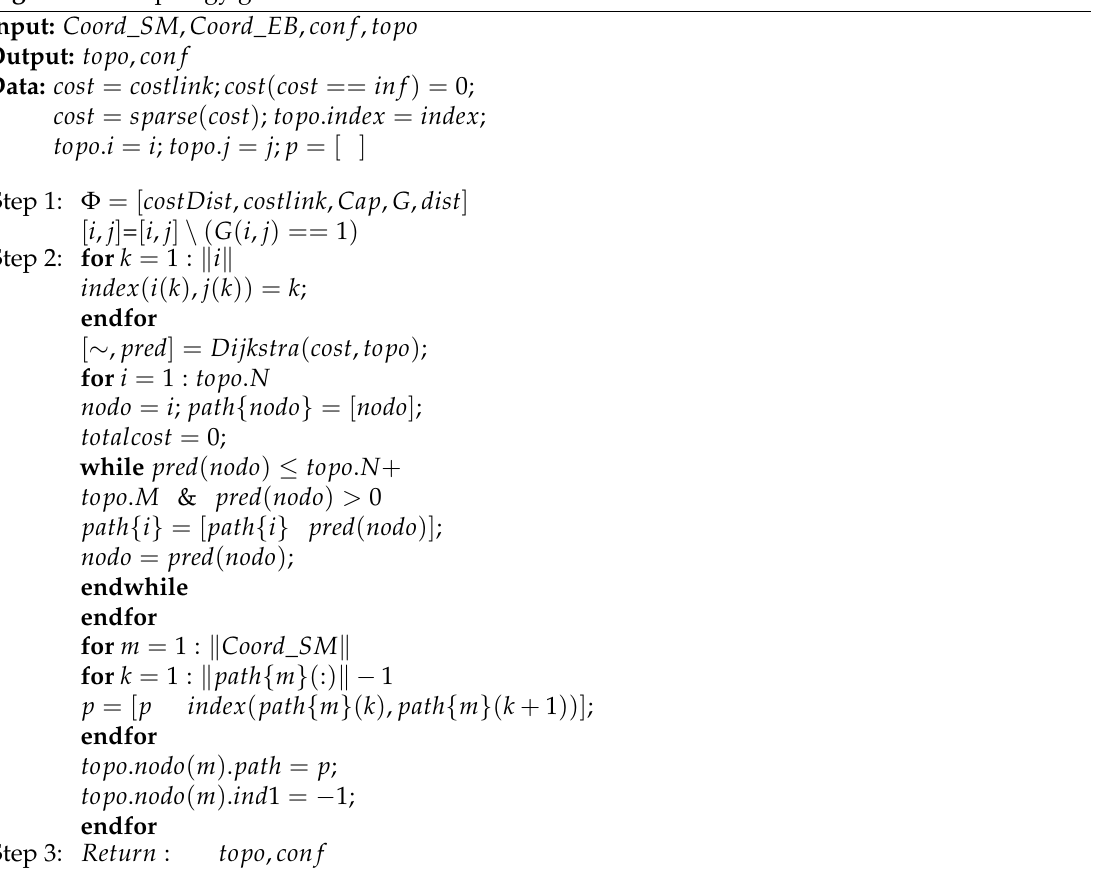
Algorithm 4 Topology generator: Φ